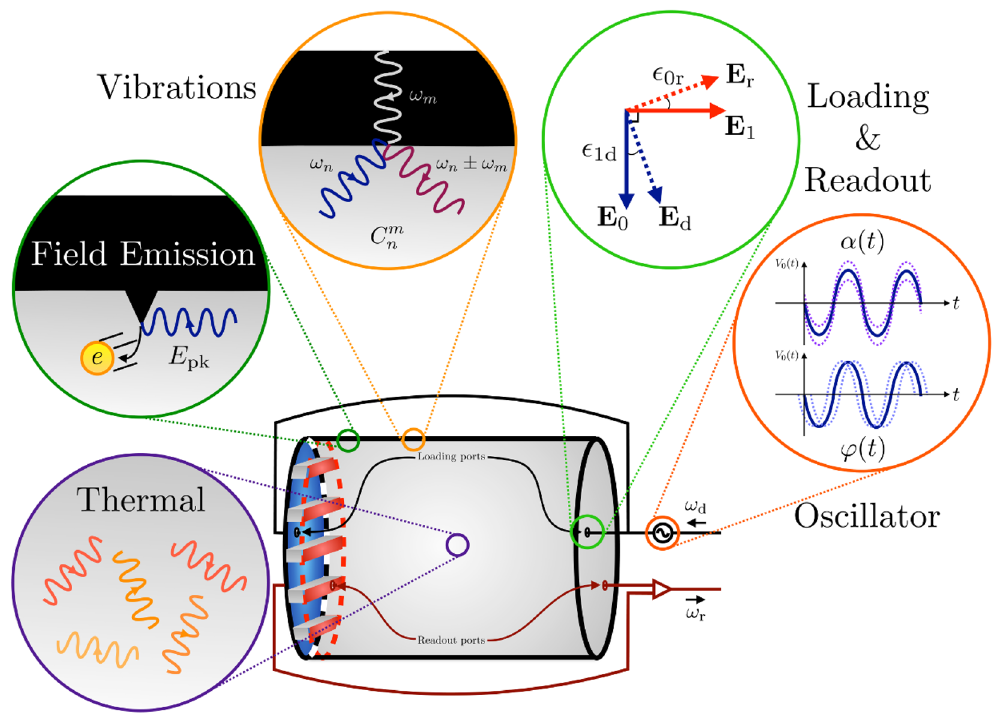
Figure 3 . A diagram depicting the main expected sources of noise speci(cid:12)c to our detection strategy. In counterclockwise order are depictions of individual noise sources: thermal emission, discussed in section 5.1; the e(cid:11)ects of oscillator phase noise, as discussed in section 5.2; the precision of the geometric coupling of the loading and readout waveguides, relevant to several noise sources; vibrations of the cavity walls, discussed in section 5.3; and (cid:12)eld emission, discussed in section 5.4. Not shown is ampli(cid:12)er noise, discussed in section